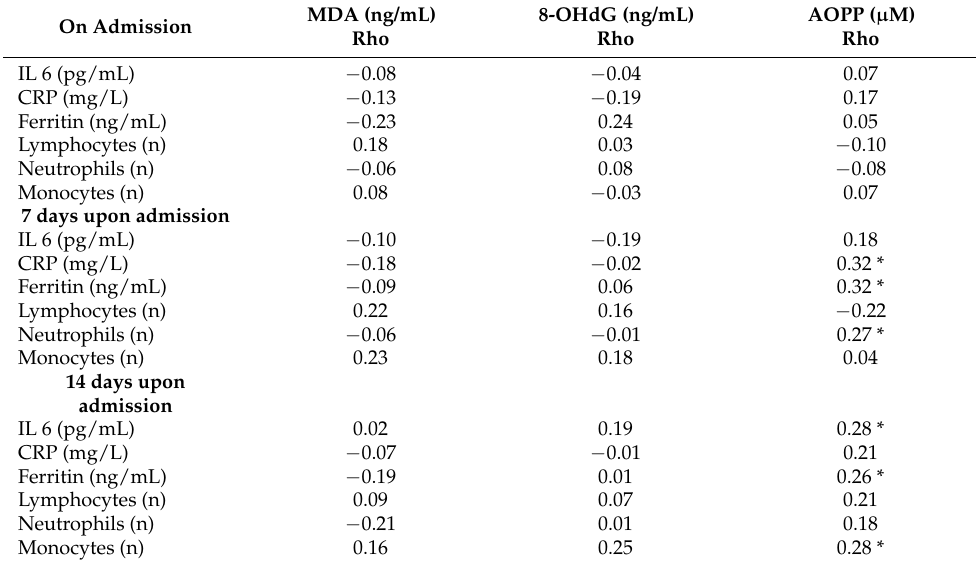
Table 4. The correlation of redox biomarkers with inflammatory biomarkers in 58 patients with COVID-19 pneumonia on admission, 7 and 14 days upon admission.